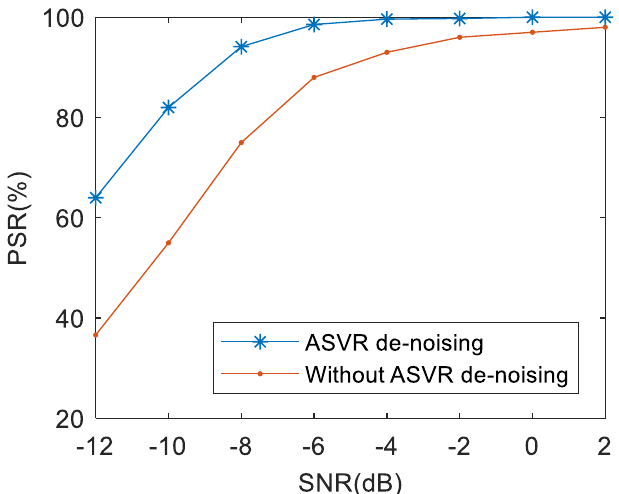
Figure 11. The effects of the ASVR denoising method on the PSR of the proposed approach.